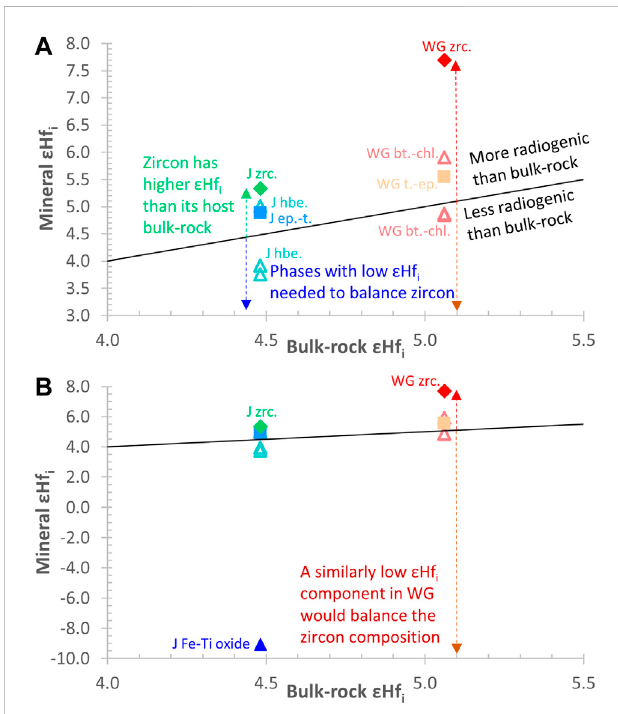
FIGURE 9 Magmatic zircon and mineral separate Hf isotope compositions from the Woodlands Granite and Site J of the MGD plotted against their host bulk-rock compositions. A 1:1 line is shown for reference. (A) To balance the radiogenic Hf in magmatic zircon, the bulk-rock samples must contain complementary low ε H fi phases, which would plot below the 1:1 line. Among the various mineral separates some capture such a component, while others are intermediate between zircon and bulk-rock. (B) The clearest example of a separate with suf fi ciently low ε H fi to balance the contribution of zircon to the bulk- rock Hf budget is the Fe-Ti oxide separate from Site